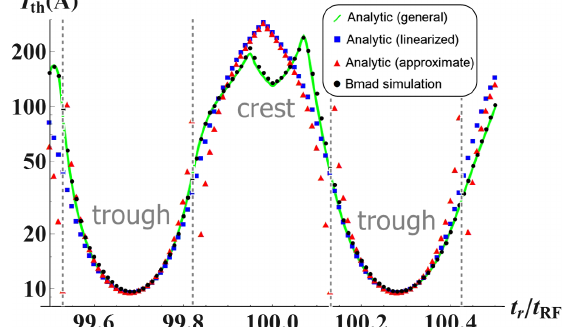
obtained from different analytic th